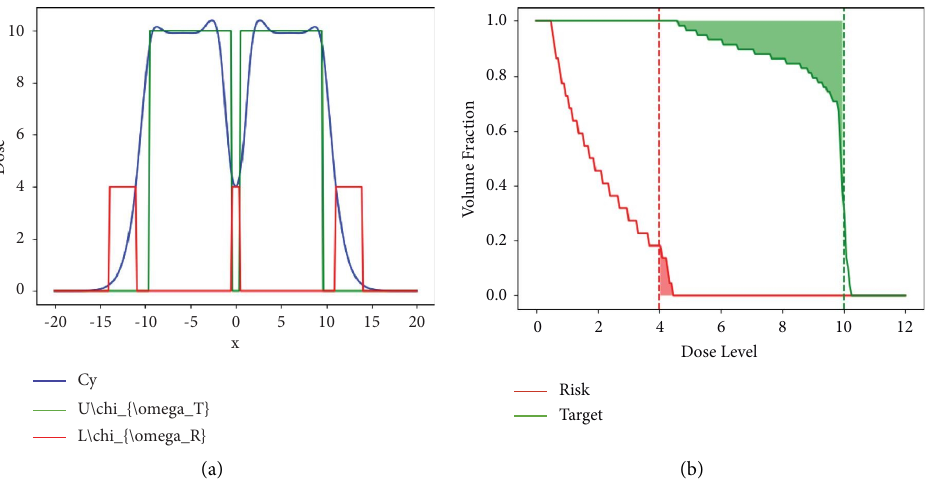
Figure 2: Dose information for dose-constrained equation (3) with 􏽥 β target level R . (b) Dose volume histogram for risk w R and target region w T .